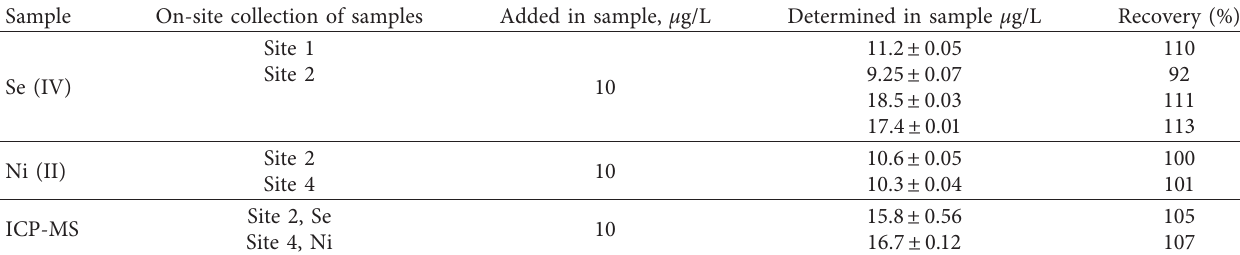
Table 3: Analytical results of real water samples collected during shutdown of factory. Sample